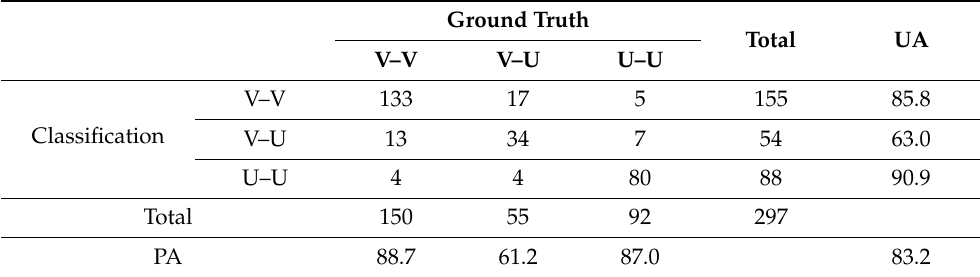
Table 8. Confusion matrix of transition types for 297 pixels accurately classified as changed.